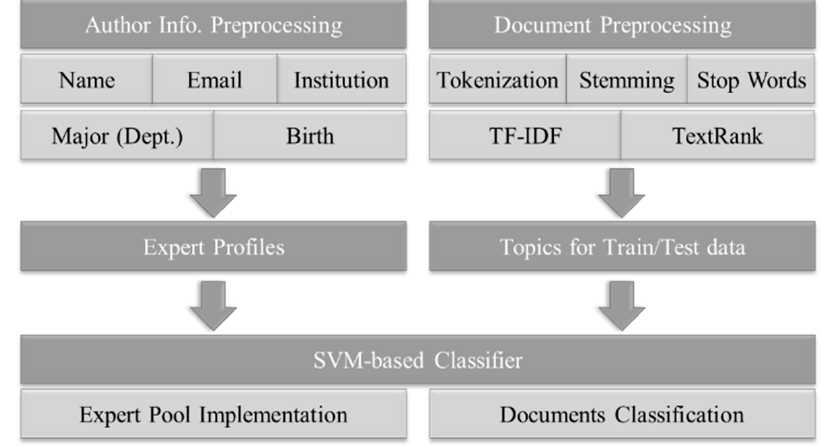
Figure 2. Document preprocessing steps.